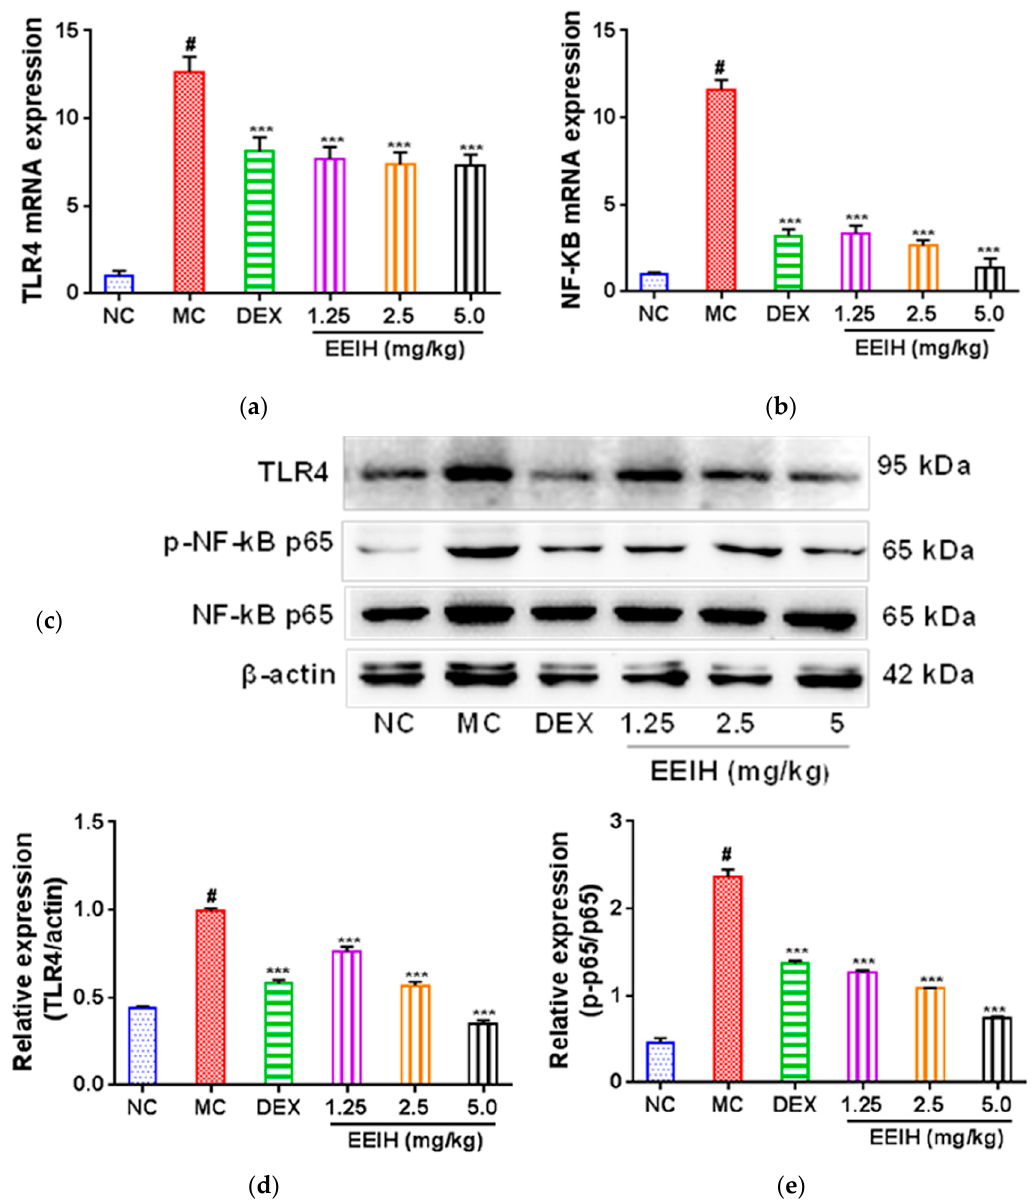
Figure 2. Effects of EEIH on the mRNA ( a , b ) and protein ( c – e ) expression levels of toll-like receptor 4 (TLR4) and nuclear factor- κ B (NF- κ B) in renal tissue of LPS-treated mice. The figure shown is representative of three independent experiments. The values are presented as the means ± SD ( n = 5). Significant differences compared to the normal control group (NC) are designated as # p < 0.001; those compared to the model control group (MC) as *** p < 0.001. DEX: dexamethasone (positive control).